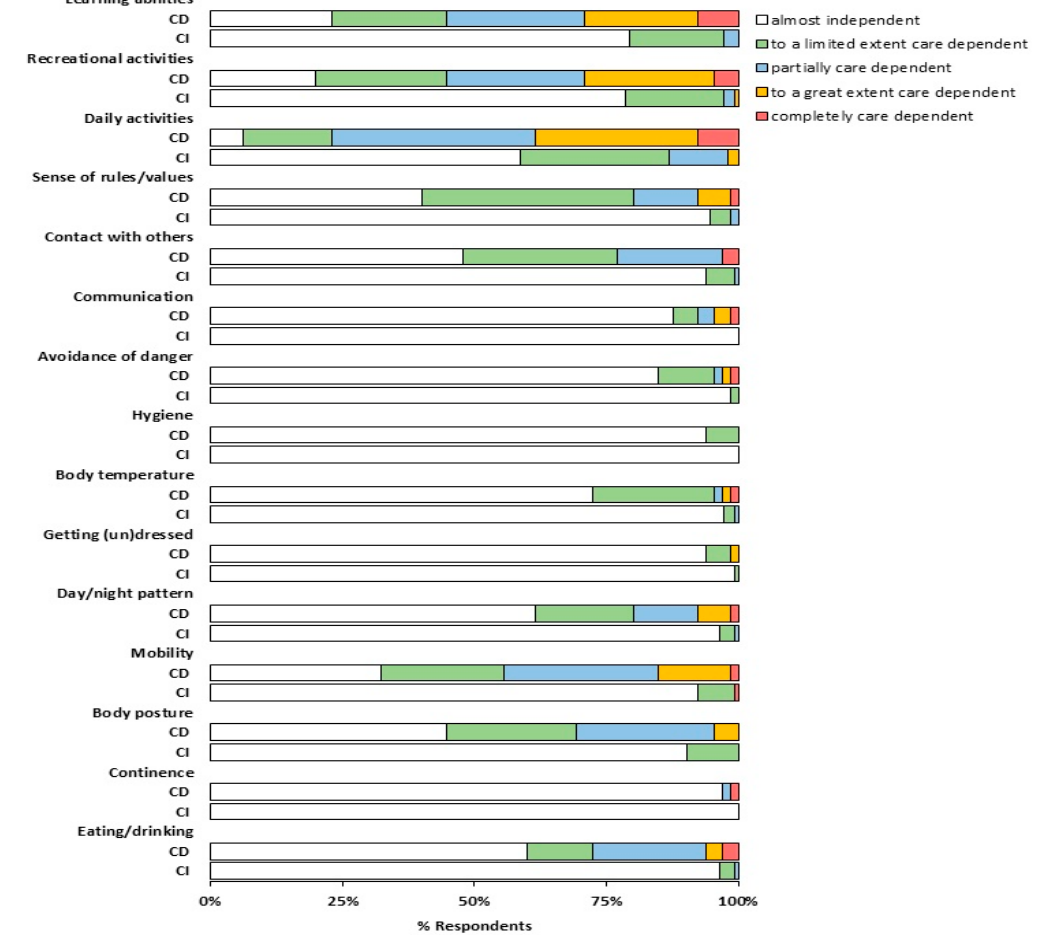
Figure 2. Care Dependency Scale (CDS) item scores for care-dependent (CD) and care-independent (CI) patients; differences in the proportion of patients across different item scores were compared using the McNemar test; care-dependent: CDS score ≤ 68 points; n = 65; care-independent: CDS score > 69 points n = 145.